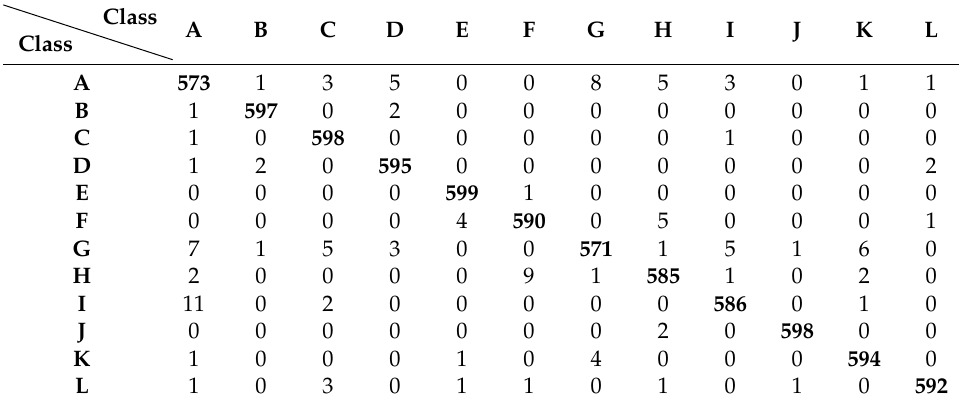
Table 14. Classification results using 3-NN secondary